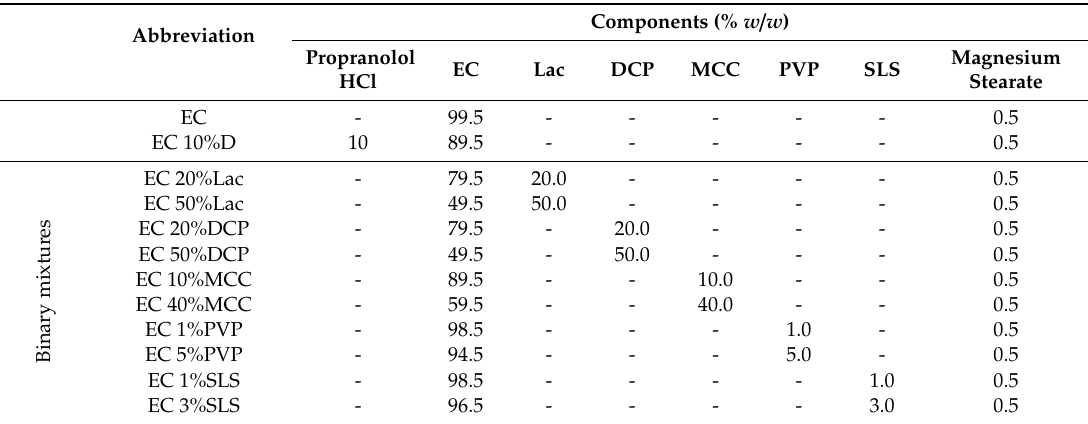
Table 3. Composition of EC-based matrix